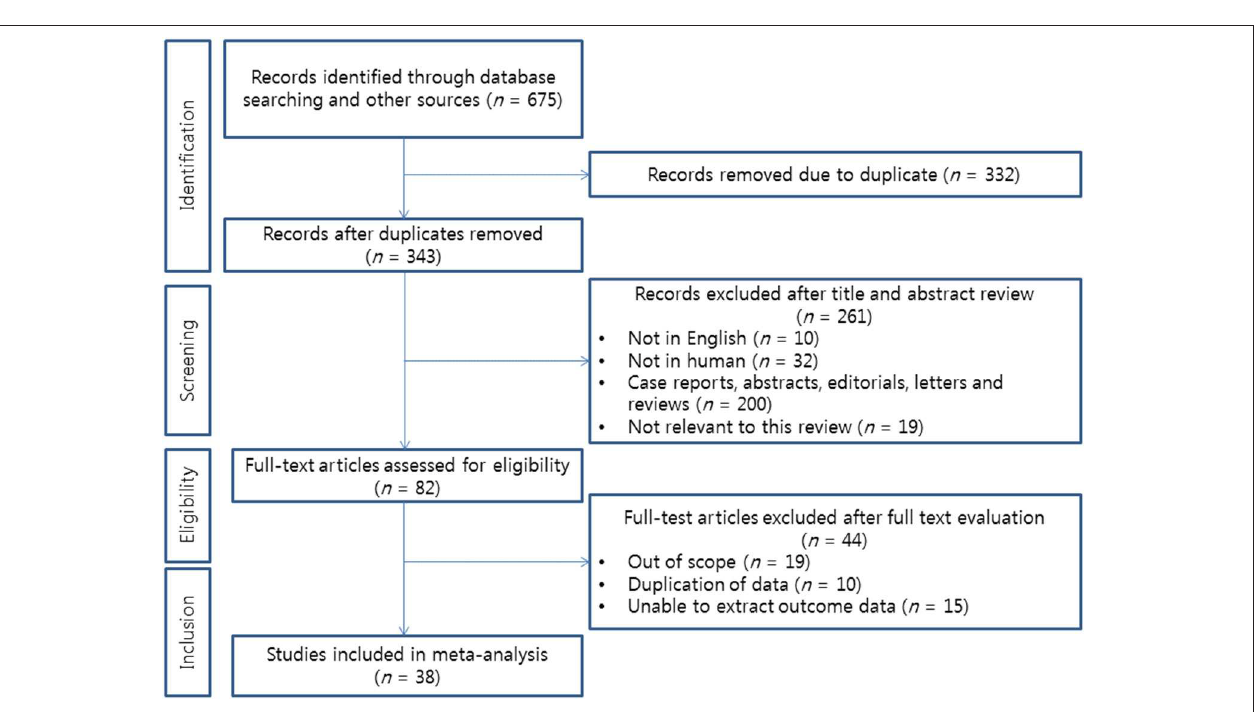
FIGURE 2 | Flow chart of the literature search for this